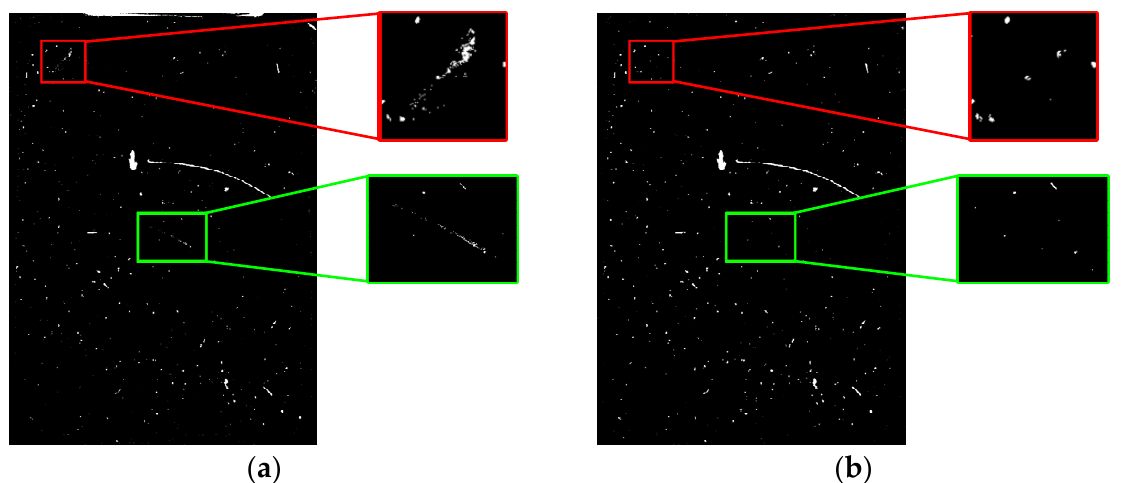
Figure 16. A partially enlarged display of the test results. ( a ) Traditional GMM detection result of frame 63; ( b ) Detection result of frame 63 based on the algorithm in this paper.